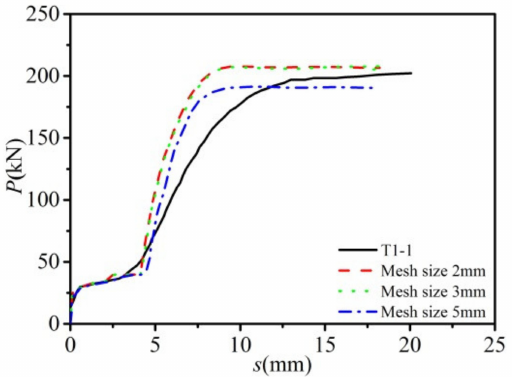
Figure 8. Effect of mesh size on load-slip relationship of T1-1